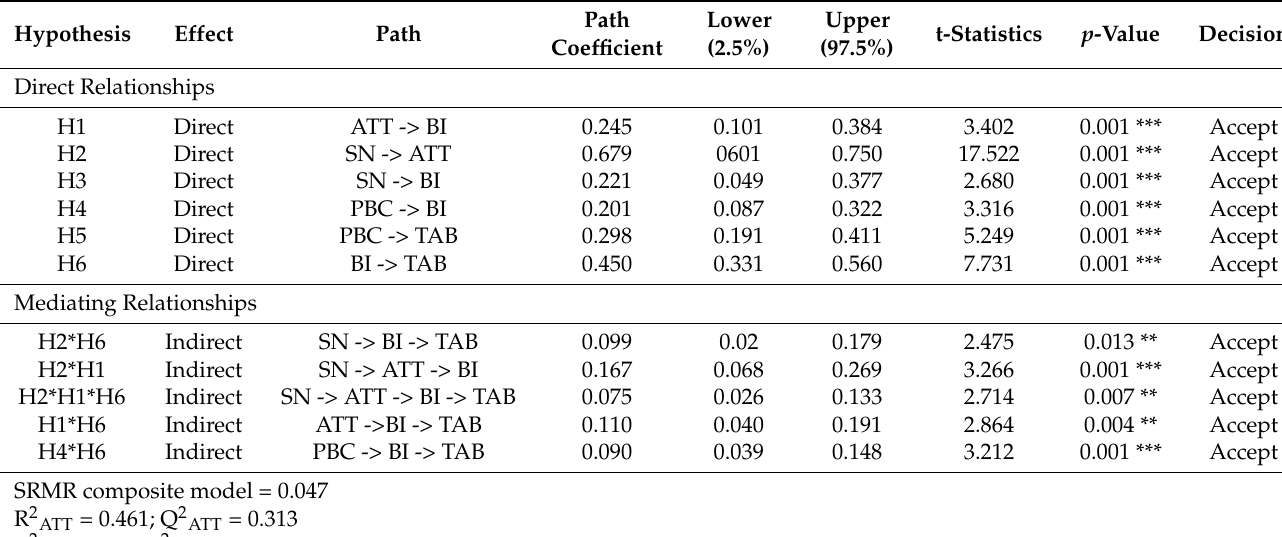
Figure 2. Path diagram of modified model. Table 6. Results of hypothesis testing.